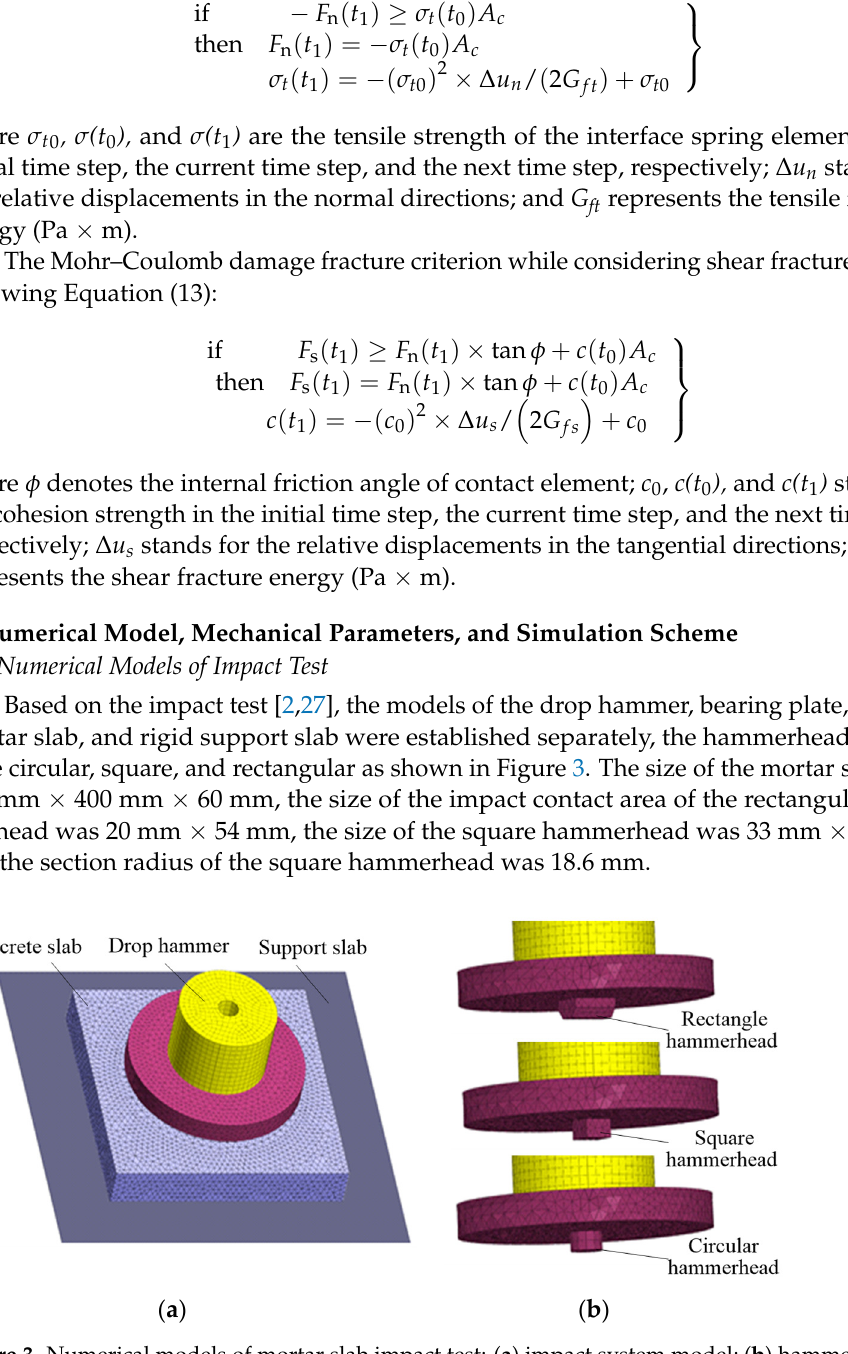
Figure 3. Numerical models of mortar slab impact test: ( a ) impact system model; ( b ) hammer model.